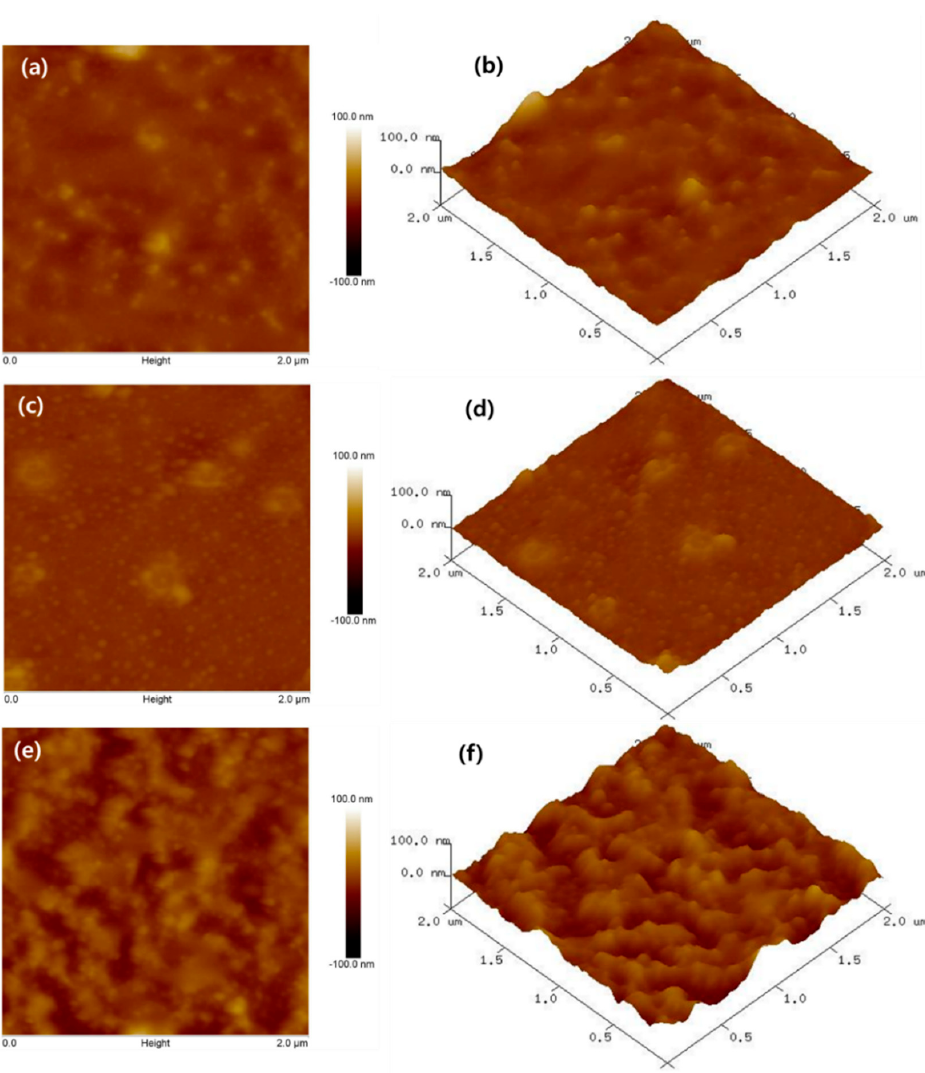
Figure 6. Representative AFM height and 3D images of ( a , b ) 1:1, w / w , ( c , d ) 1:2, w / w and ( e , f ) 1:3, w / w of DVB-T-ID:PC 61 BM blend thin films. Table 2. Summary of photovoltaic parameters of the fabricated and reported BHJ-OSCs.